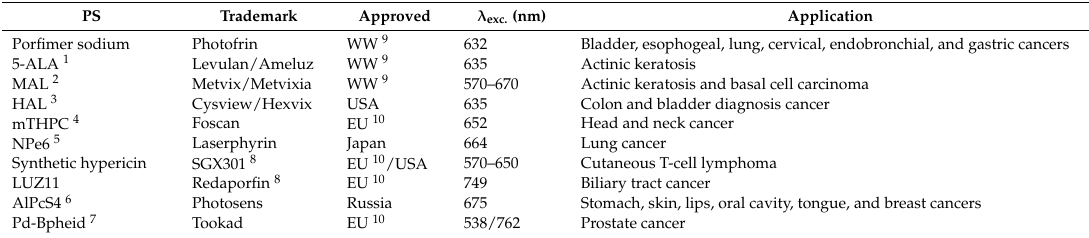
Table 2. Overview of clinically approved PSs for PDT as cancer treatment.